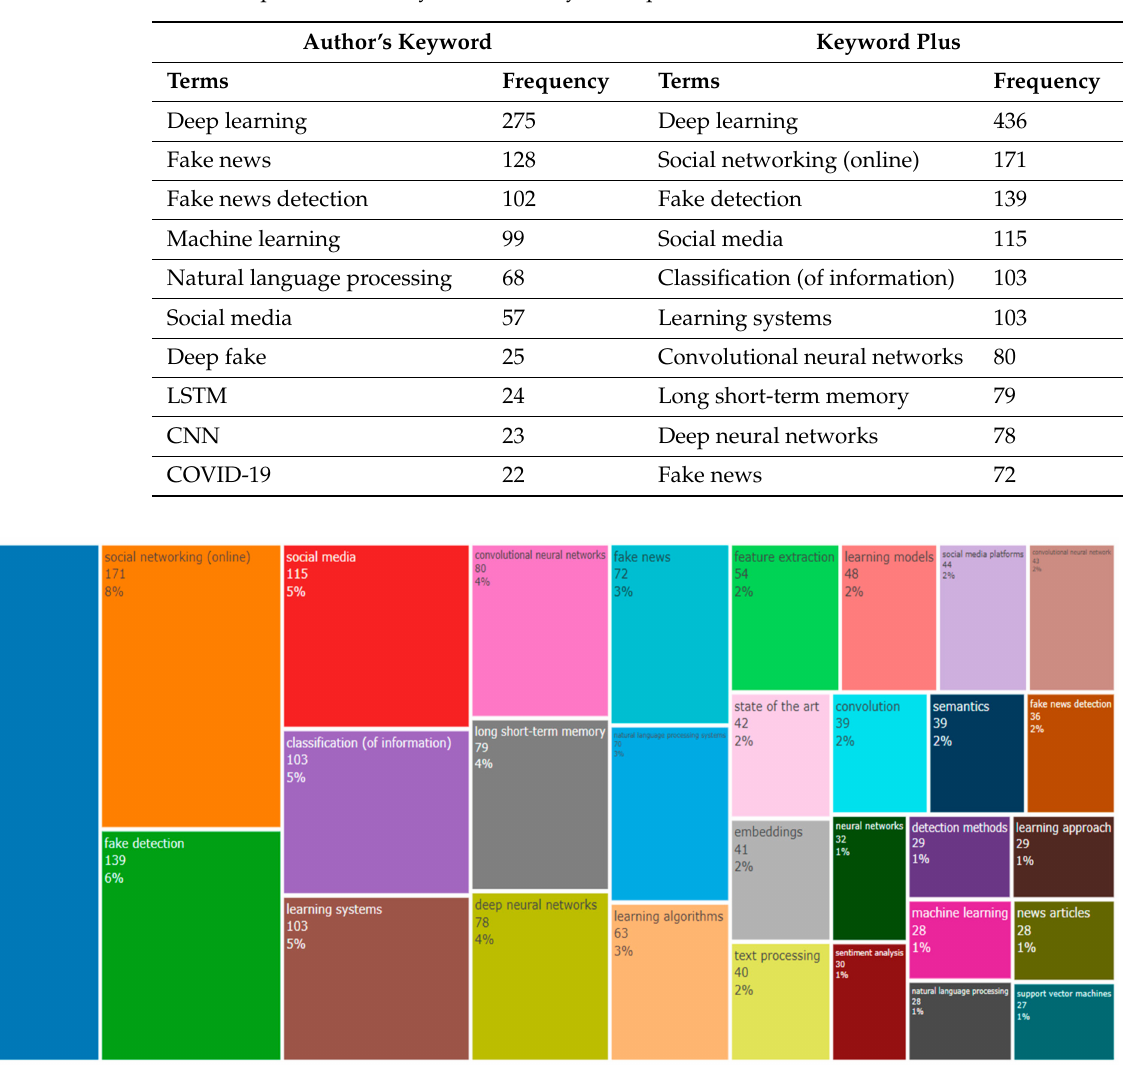
Table 5. Top 10 authors’ keywords and keywords plus.